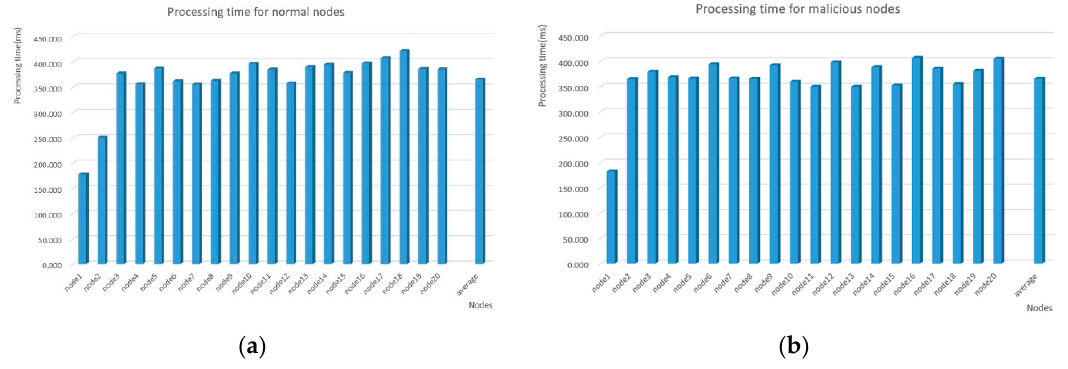
Figure 9. ( a ) Processing time for normal nodes; and, ( b ) Processing time for malicious nodes.